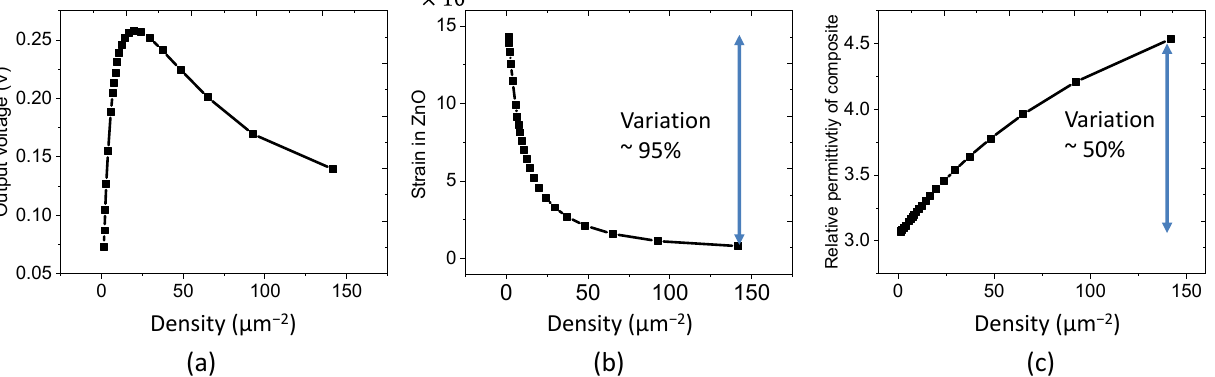
Figure 8. Effect of ZnO NW density on: ( a ) the generated output voltage; ( b ) the strain in ZnO along the stress direction; and ( c ) the relative permittivity of the composite.